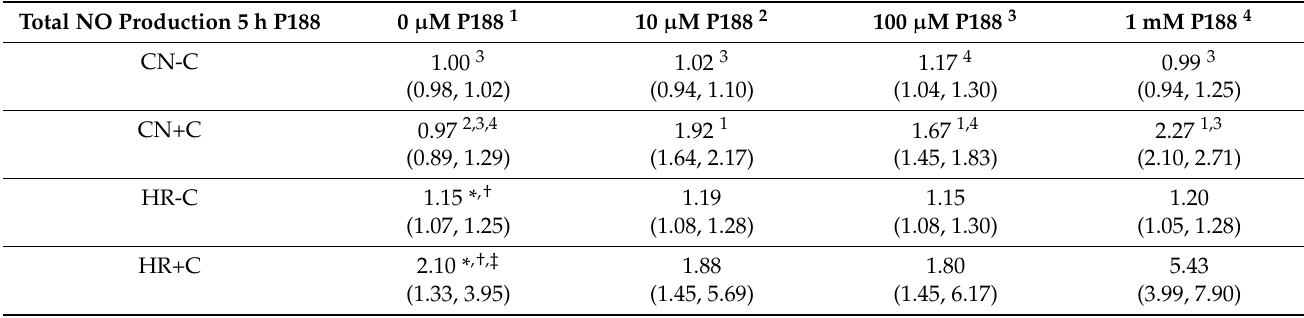
Table A4. Total NO production after 5 h injury and treatment with 0 µ M, 10 µ M, 100 µ M, and 1 mM of P188. Data from Figure 7 visualized as table (median, 25th, 75th percentile); p < 0.05; n = 8–10 experiments/group. Significances between different concentrations of P188 are displayed as superscripted numbers, significances between 0 µ M P188 CN-C, CN+C, HR-C, and HR+C are represented by symbols (* vs. CN-C 0 µ M P188, † vs. CN+C 0 µ M P188, ‡ vs. HR-C 0 µ M P188). Abbreviations: C, compression; CN, control/normoxia;